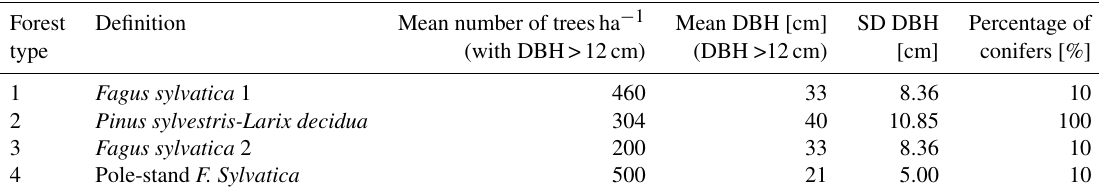
Table 2. Characteristics of the different forest types used for the rockfall simulations. Values have been taken form the Swiss National Forest Inventory (NFI) data sets published in Messmer